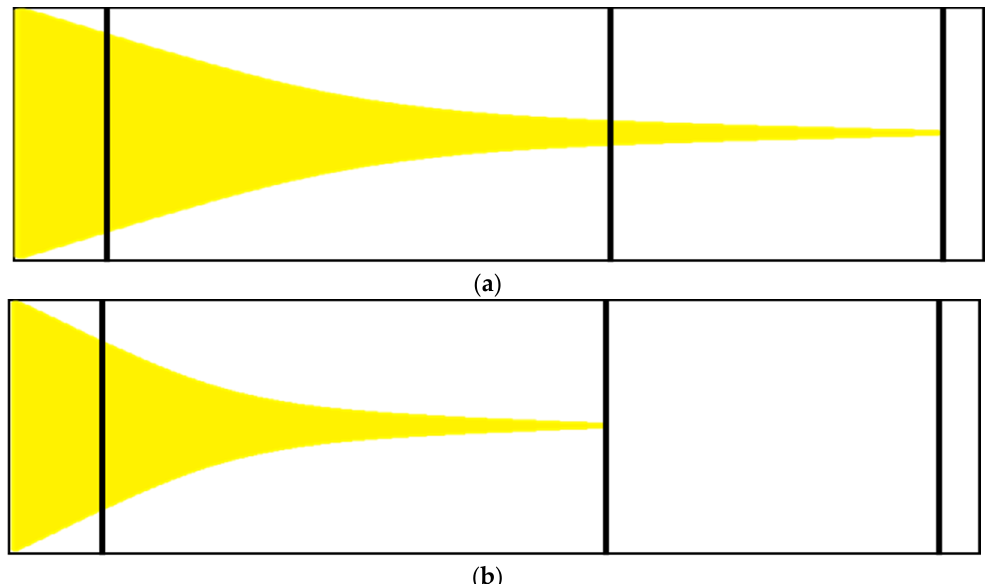
Figure 3. Examples of explicit and implicit boundaries for same lithological stratum. ( a ) Explicit boundaries; ( b ) implicit Figure 3. Examplesofexplicitandimplicitboundariesforsamelithologicalstratum. ( a )Explicitboundaries; ( b boundaries.